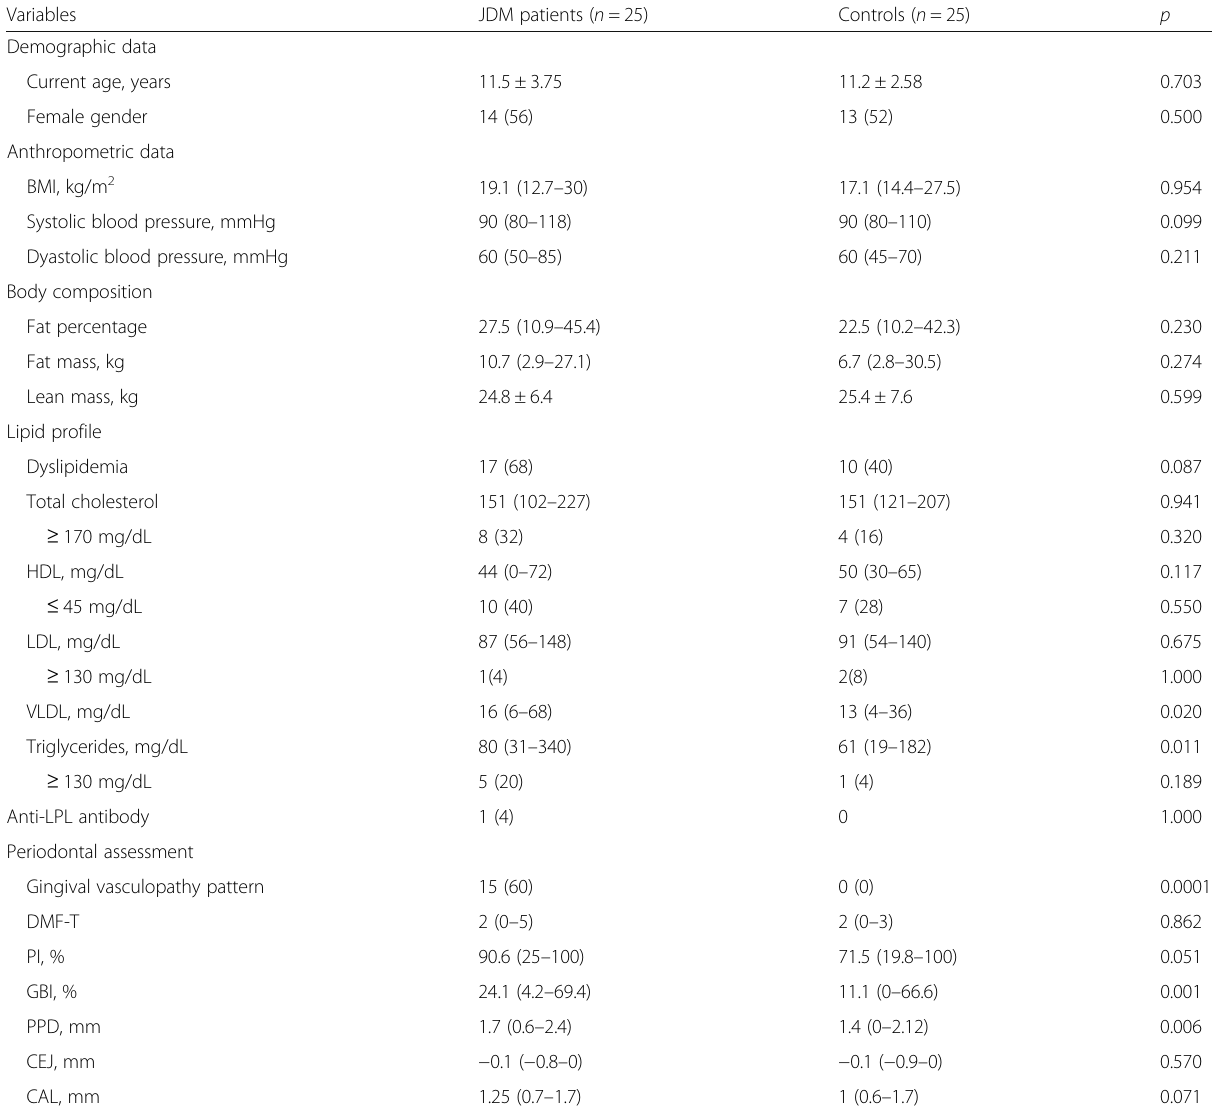
Table 1 Demographic and anthropometric data, body composition, laboratorial findings and periodontal evaluation in juvenile dermatomyositis (JDM) patients and healthy controls